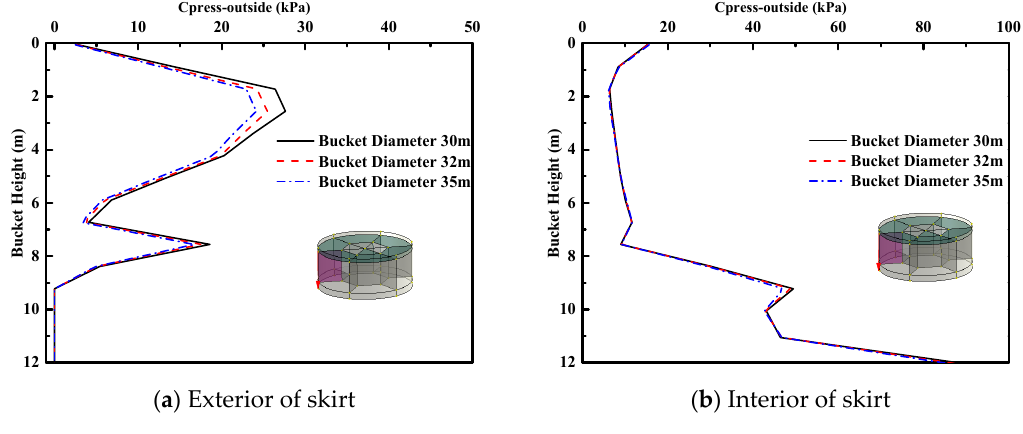
Figure 18. Contact stress of skirt under different bucket diameter.